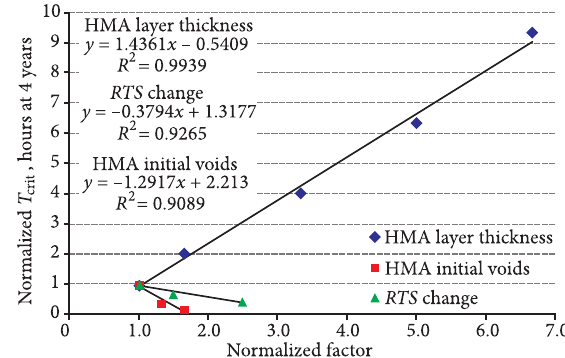
Fig. 5. Examples of effects of factors on critical